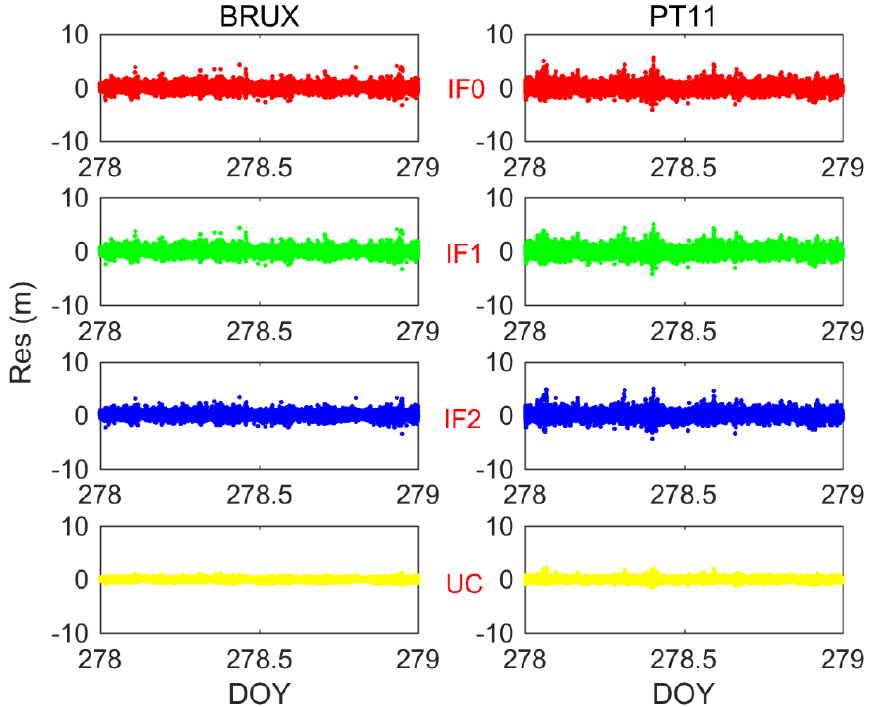
Figure 16. Analysis of the pseudorange observation residuals for all observed Galileo satellites for IF0, IF1, IF2, and UC models.